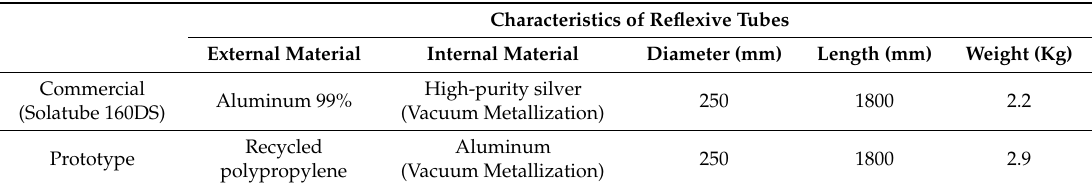
Table 3. Main features of reflective tubes.